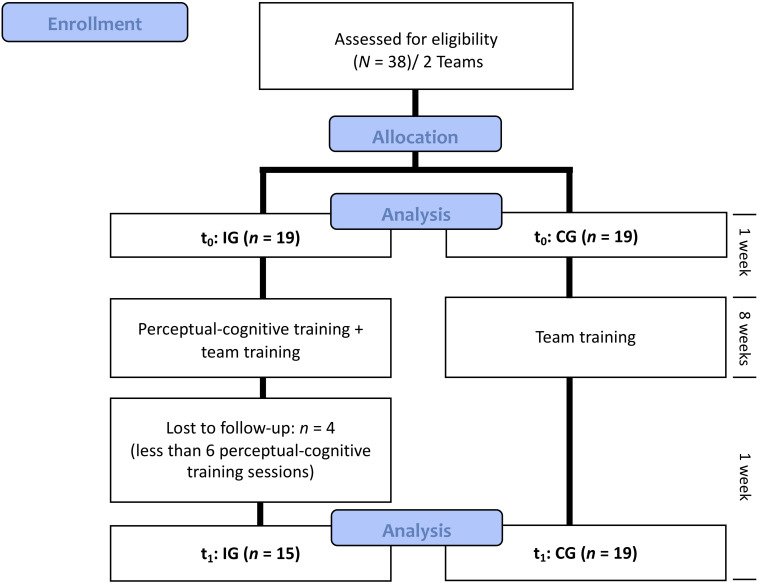
Study flowchart.